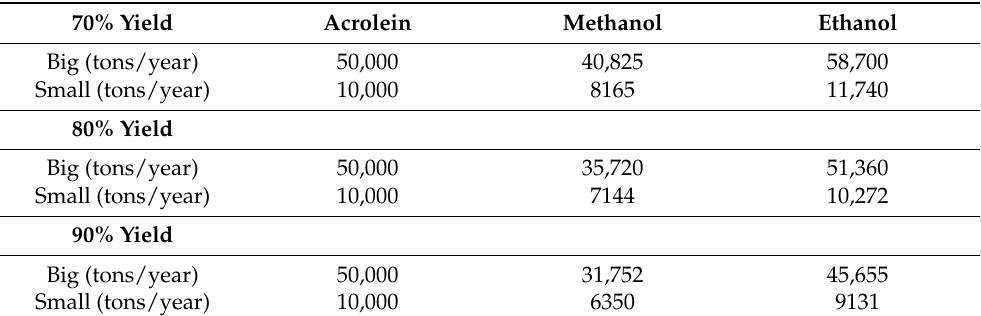
Table 1. Mass balance for big (50,000 tons/year) and small (10,000 tons/year) plants for 70, 80 and 90%